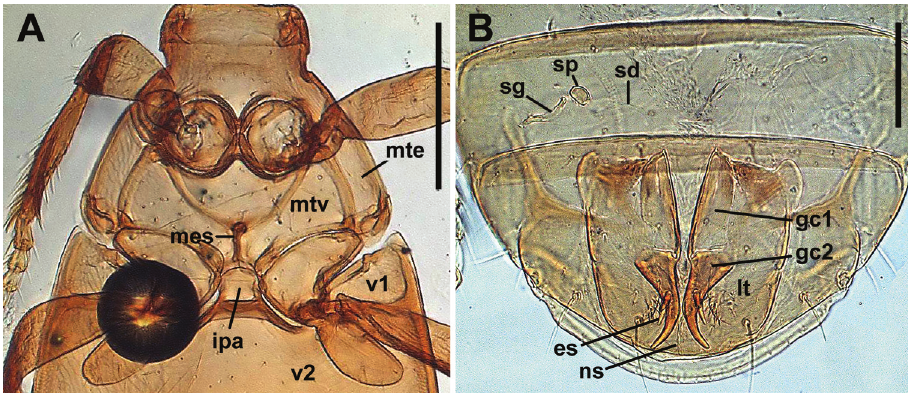
Figure 3. Digital images of pterothorax of Pelodiaetus sulcatipennis ( A ) and last abdominal ventrites with female genitalia ( B ), ventral aspect. Abbreviations: ipa – intercoxal process of abdominal ventrite 2; mes – metendosternite; mte – metanepisternum; mtv – metaventrite; v1-v2 – abdominal